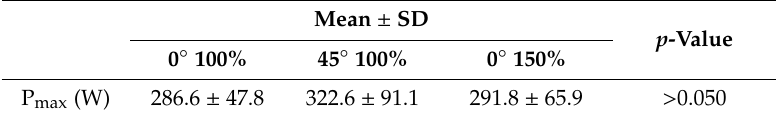
Table 2. Mean, SD, p -value and e ff ect size for the P max comparing the conditions executed at the controlled velocity.